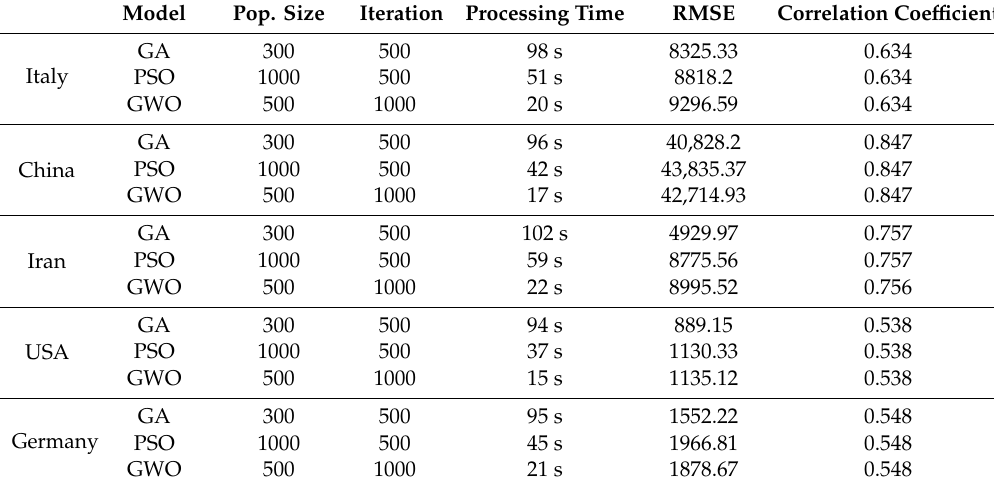
Table 5. Accuracy statistics for the logarithmic